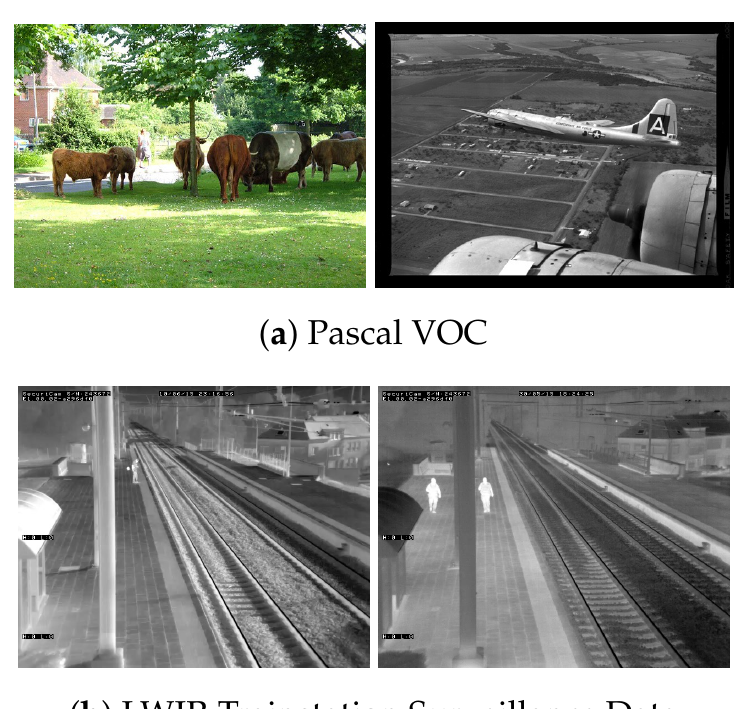
unnoticeably. We thus split the 28 different sequences into 3 subsets, trying to match the 65-10-25% split from VOC. The video sequences in each split are listed in Table 2 and the number of images in each split are found in Table 1.